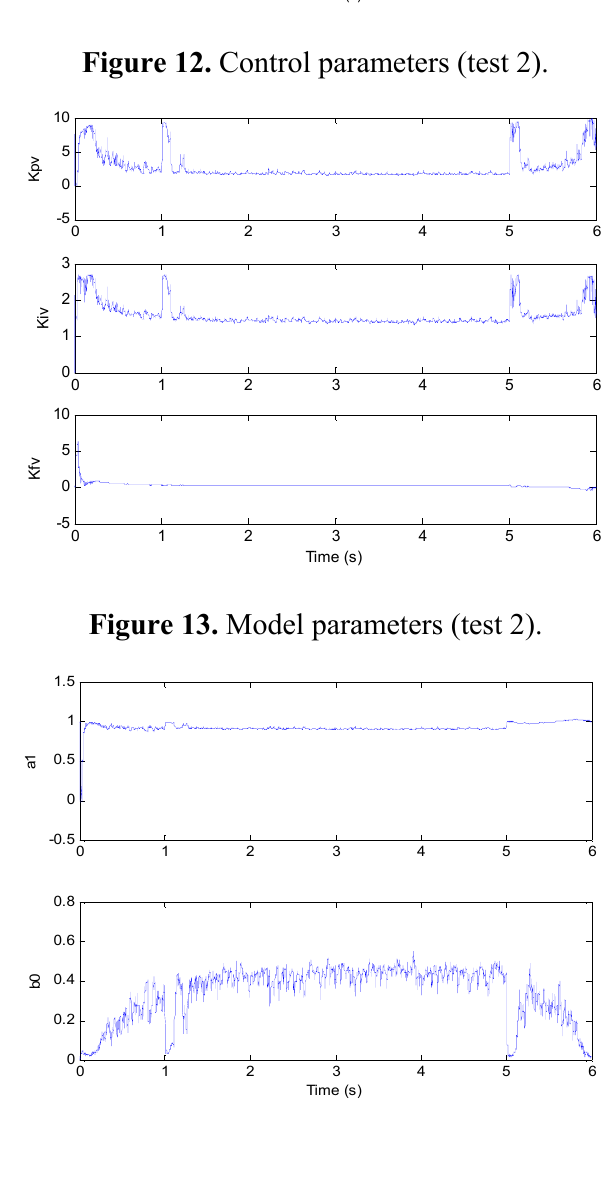
Figure 12. Control parameters (test 2).